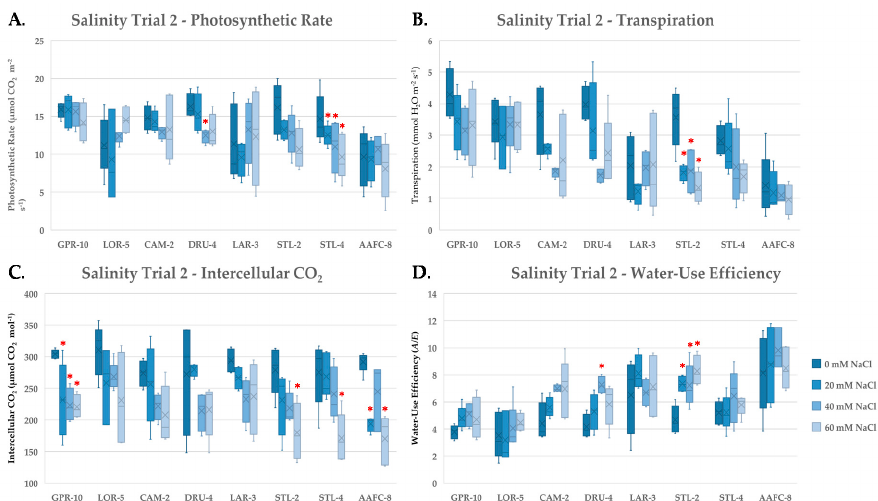
Figure 3. Assimilation rate ( A ), transpiration ( B ), intercellular CO 2 ( C ), and instantaneous water-use efficiency ( D ) (+/- SEM) of balsam poplar, native, and hybrid willow genotypes recorded at week 6 and of treatment. Control, low, moderate, and high treatments represent 0, 20, 40, and 60 mM NaCl, respectively (n ranged between 4 and 5 for each genotype and treatment). Asterisks represent significant difference from control treatments ( p < 0.05). Int. J. Environ. Res. Public Health 2020 , 17 , x